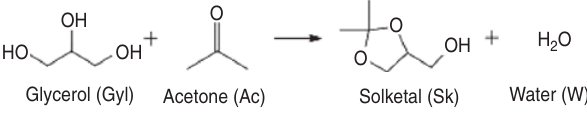
Figure 1: Acetalization of glycerol with acetone to yield solketal and water as a